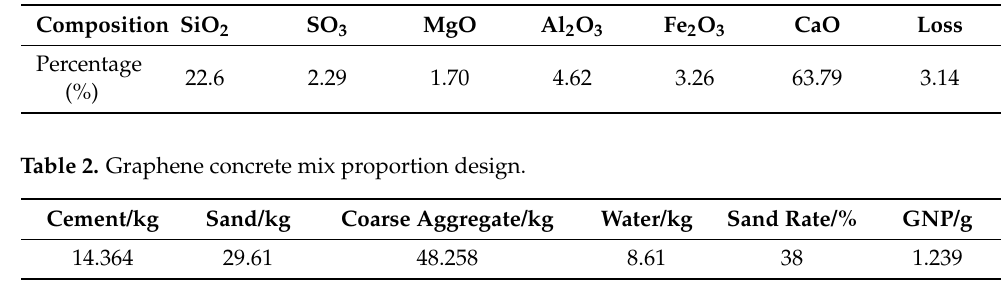
Table 1. The main chemical properties of cement.